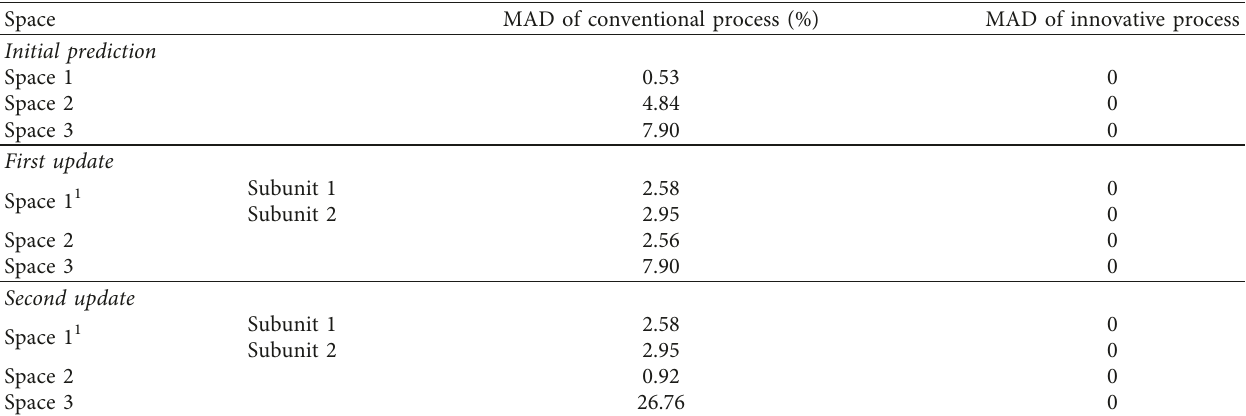
Table 6: MADs of the three Case 2 trials.